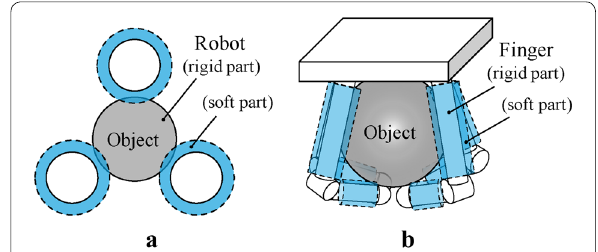
Fig. 2 Caging-based grasping approach. a 2D and b 3D